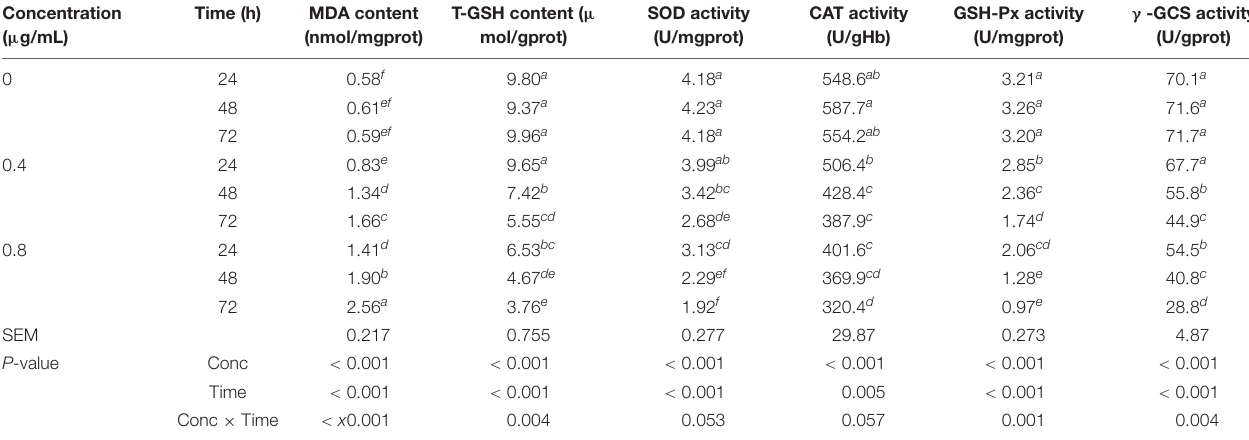
TABLE 8 | Effects of α -chaconine on the antioxidant ability of mouse intestinal epithelial cells. Concentration Time (h) MDA content ( µ g/mL) (nmol/mgprot)